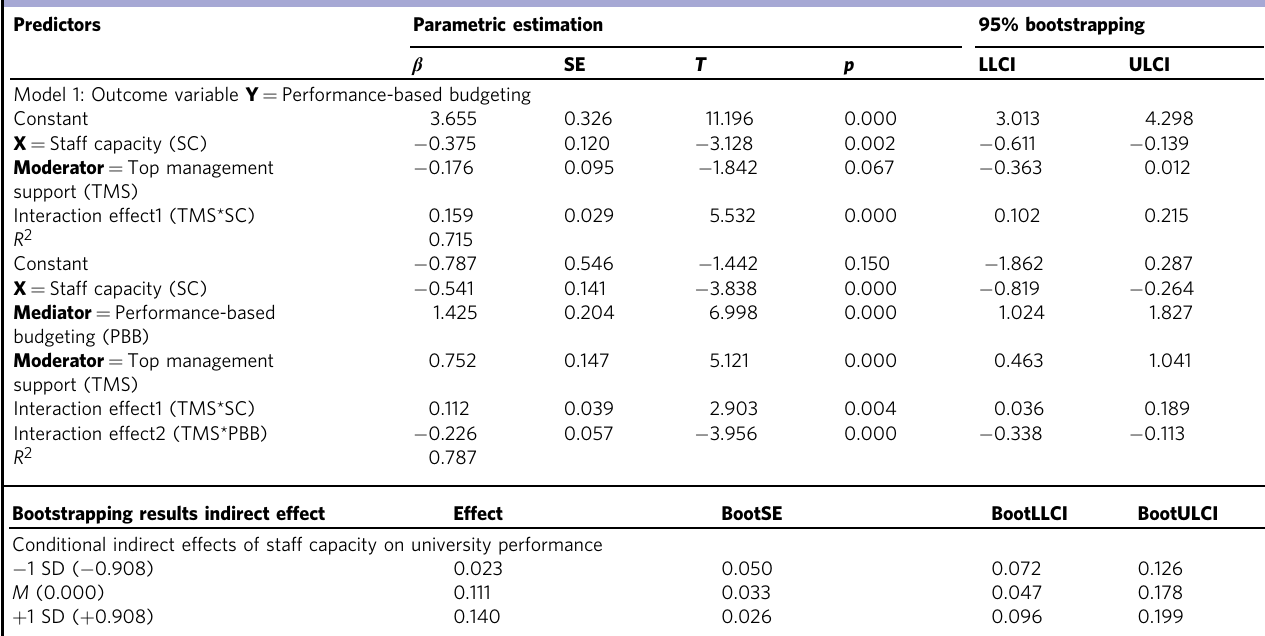
Table 6 Results of the moderated mediation